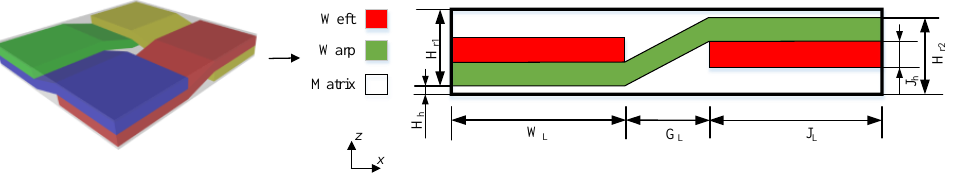
Figure 5. The uncertain geometry of weave composite.